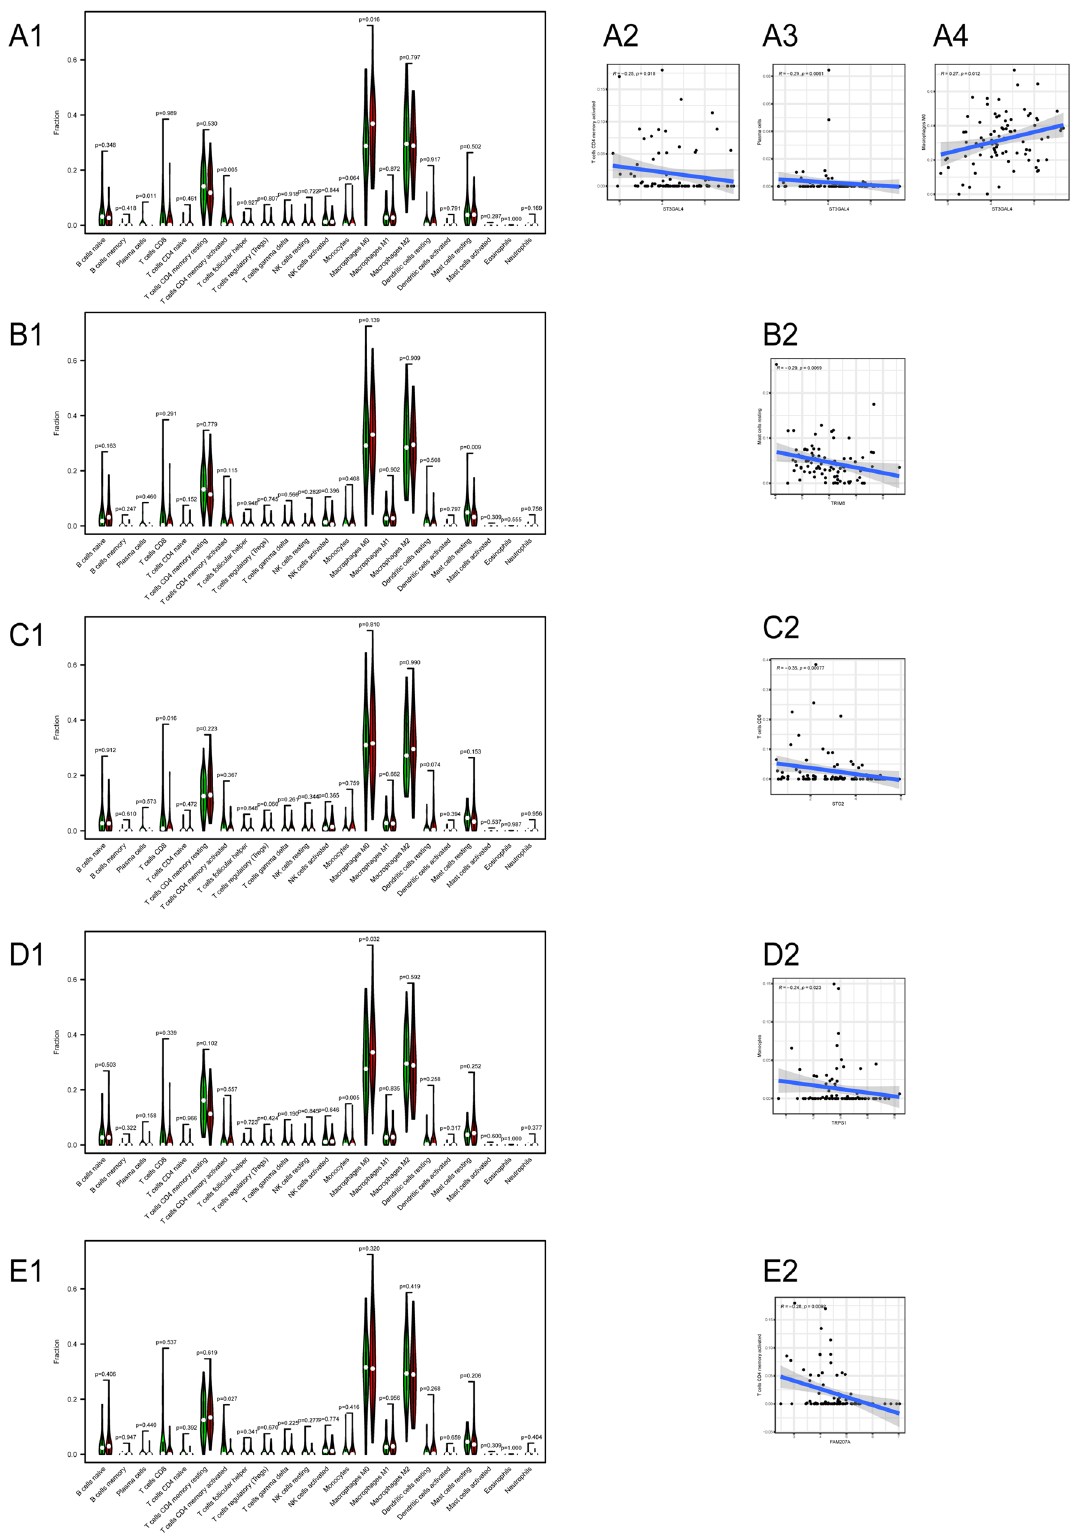
Figure 5. Violin diagram and correlation diagram of immune cells. ( A1 ) Violin diagram showing the difference in the degree of infiltration of 22 immune cells based on the ST3GAL4 gene in osteosarcoma; ( A2 – A4 ) indicate the correlation between ST3GAL4 and three different immune cells. ( B1 ) The difference in the infiltration of 22 kinds of immune cells based on the TRIM8 gene in osteosarcoma. ( B2 ) The infiltration correlation between TRIM8 and resting mast cells. ( C1 ) The difference in the infiltration of 22 kinds of immune cells based on the STC2 gene in osteosarcoma. ( C2 ) The correlation between STC2 and CD8 + T cell infiltration. ( D1 ) The difference in the infiltration of 22 kinds of immune cells based on the TRPS1 gene in osteosarcoma. ( D2 ) The infiltration correlation between TRPS1 and monocytes. ( E1 ) The difference in the infiltration of 22 immune cells based on the FAM207A gene in osteosarcoma. ( E2 ) The correlation between STC2 and memory-activated CD4 + T cell